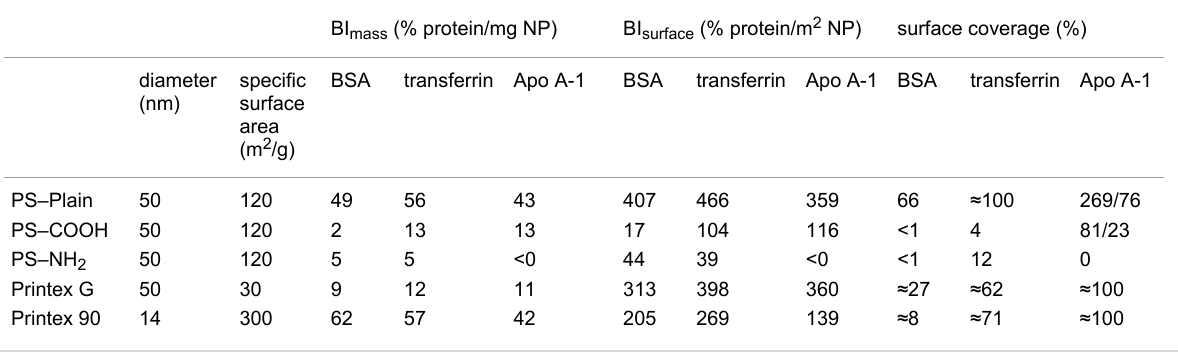
Table 1: Mass and surface area related to binding indices BI of the NP to the three different proteins, albumin, transferrin and apolipoprotein A-1. Reproduced with permission from [5]. Copyright 2011 Informa Plc. Diameter refers to the geometrical diameter as observed with transmission elec- tron microscopy (TEM), and does not take into account the hydration shell and adsorbed counter ions [6]. BI mass (% protein/mg NP)